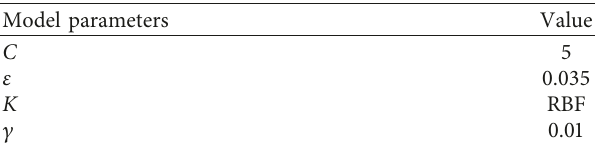
Figure 8: Measured versus predicted IRI t using the ANN model: validation data. Table 1: SVM model parameters. Model parameters